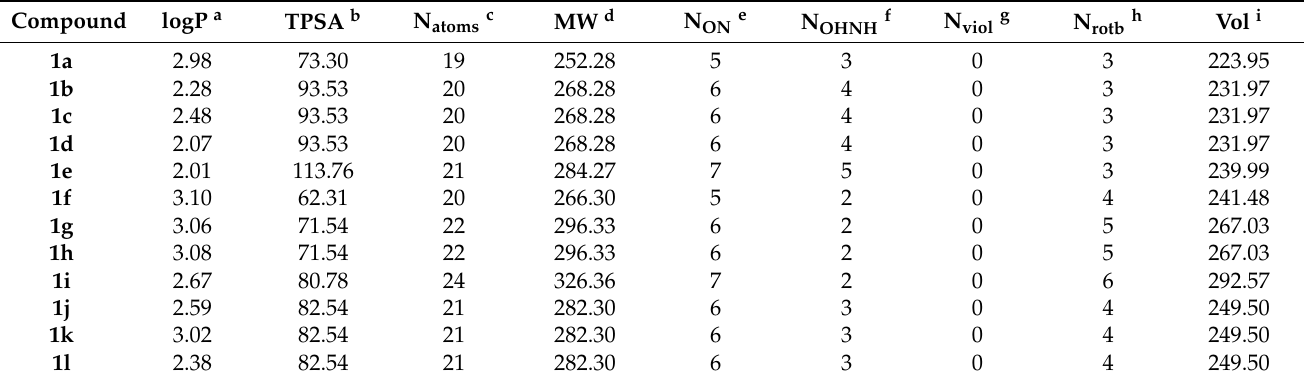
Table 3. Calculated molecular properties of compounds 1a-l for assessment of the